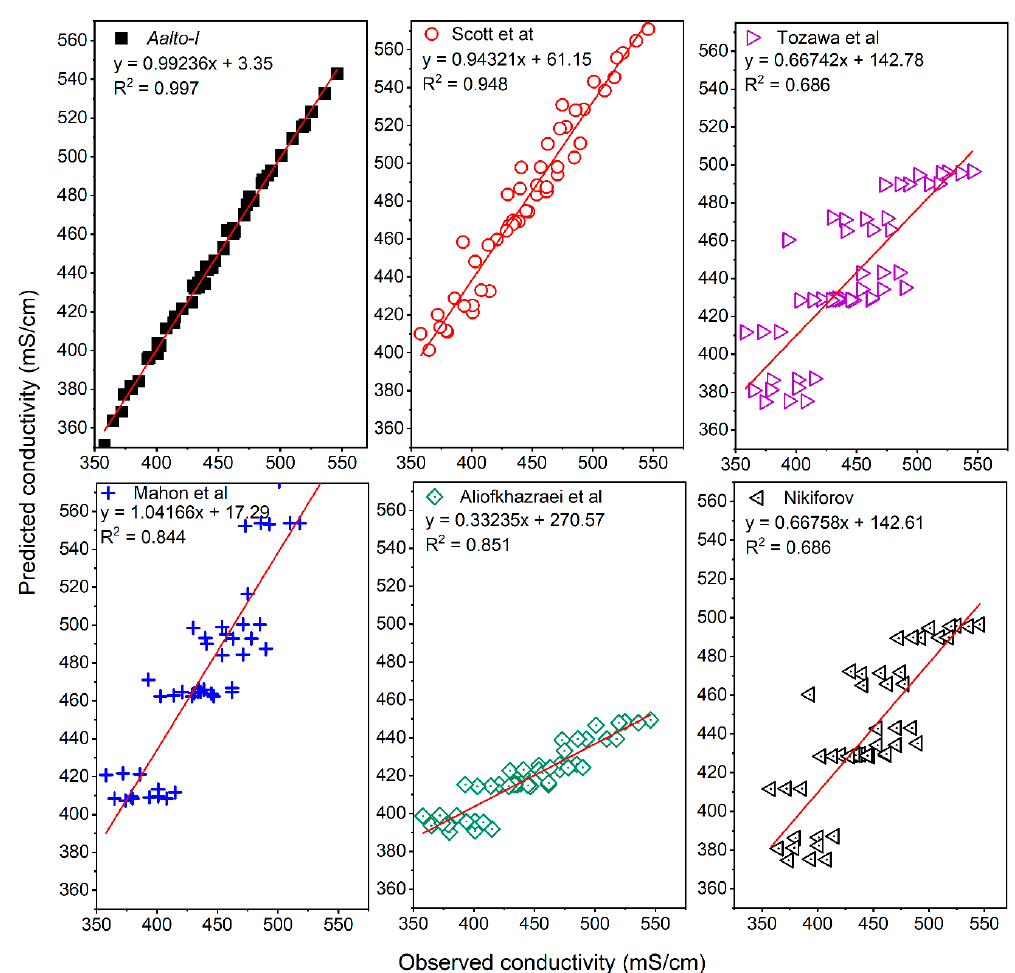
Figure 5. Measured (synthetic Zn electrolyte) vs. predicted conductivity by Nikiforov et al. (1971), Scott et al. (1988), Mahon et al. (2012), Tozawa et al. (1993), and Aliofkhazraei et al. (2007) [15–19].